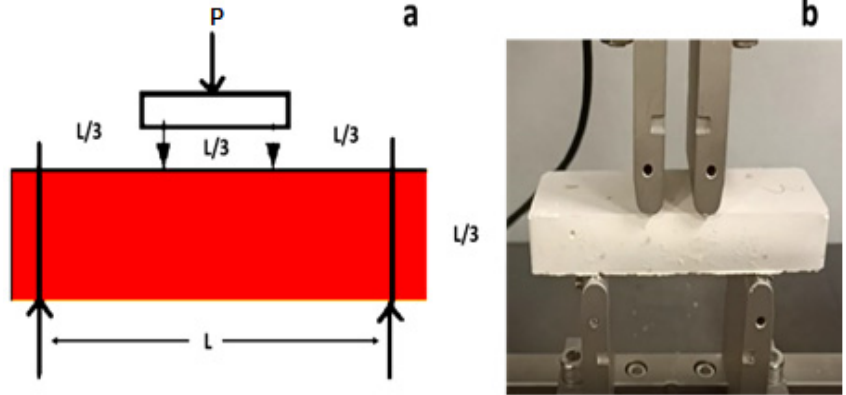
Figure 1. ( a ) Scheme of the four-point flexural test. ( b ) Flexural test experimental setup.